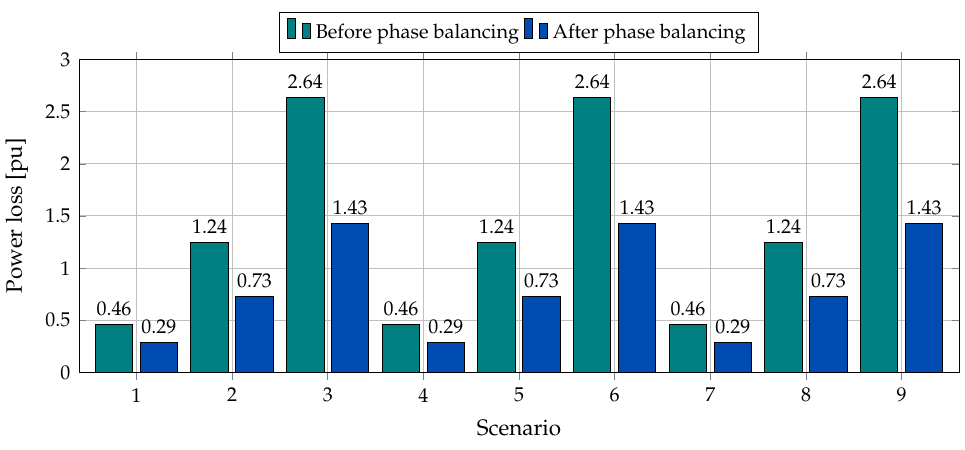
Figure 5. Power loss behavior for each one of the scenarios